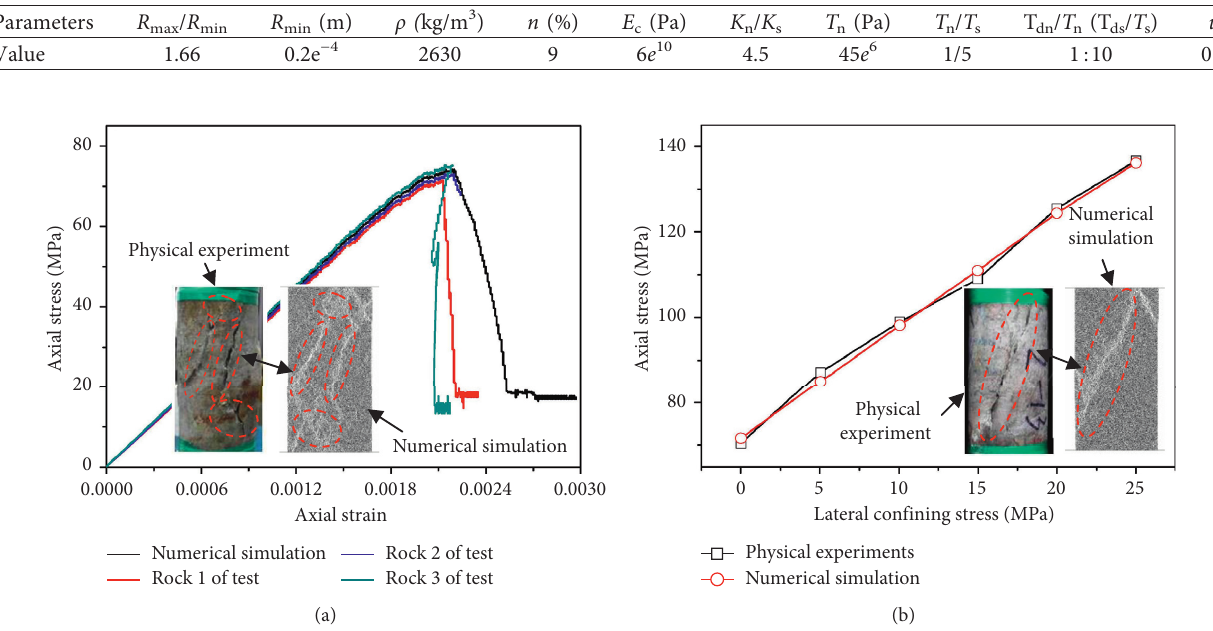
Table 1: The microscopic parameters of the PFC 2D numerical model.